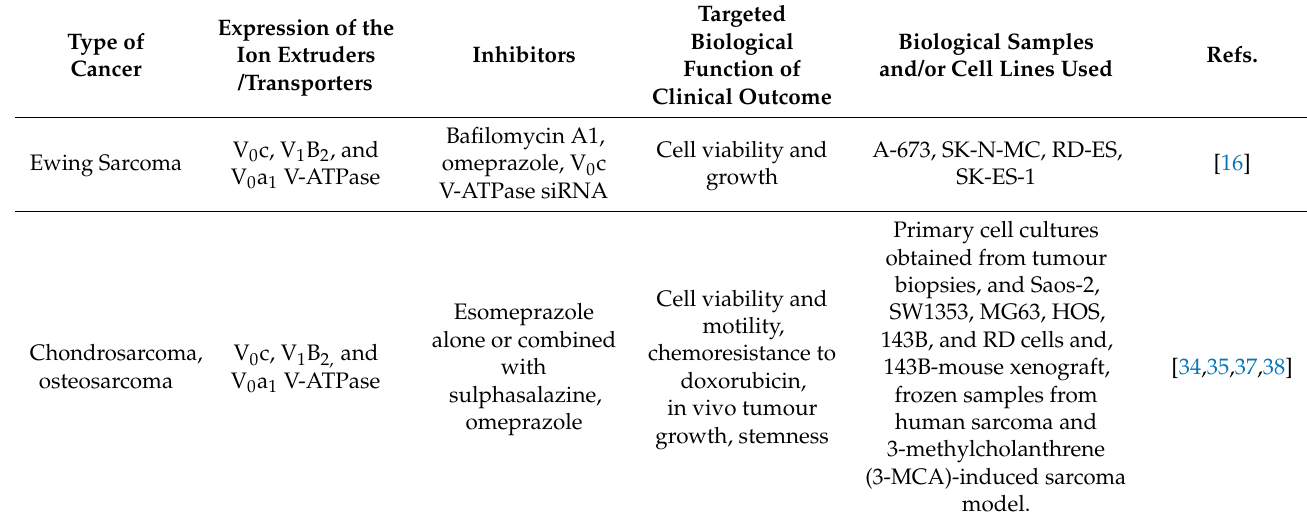
Table 1. V-ATPase expression and targeting in bone sarcomas.